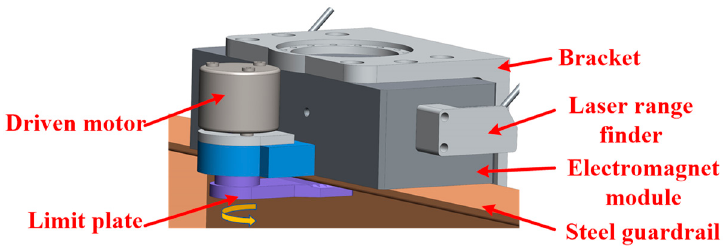
Figure 3. Schematic diagram of the magnetic feet.